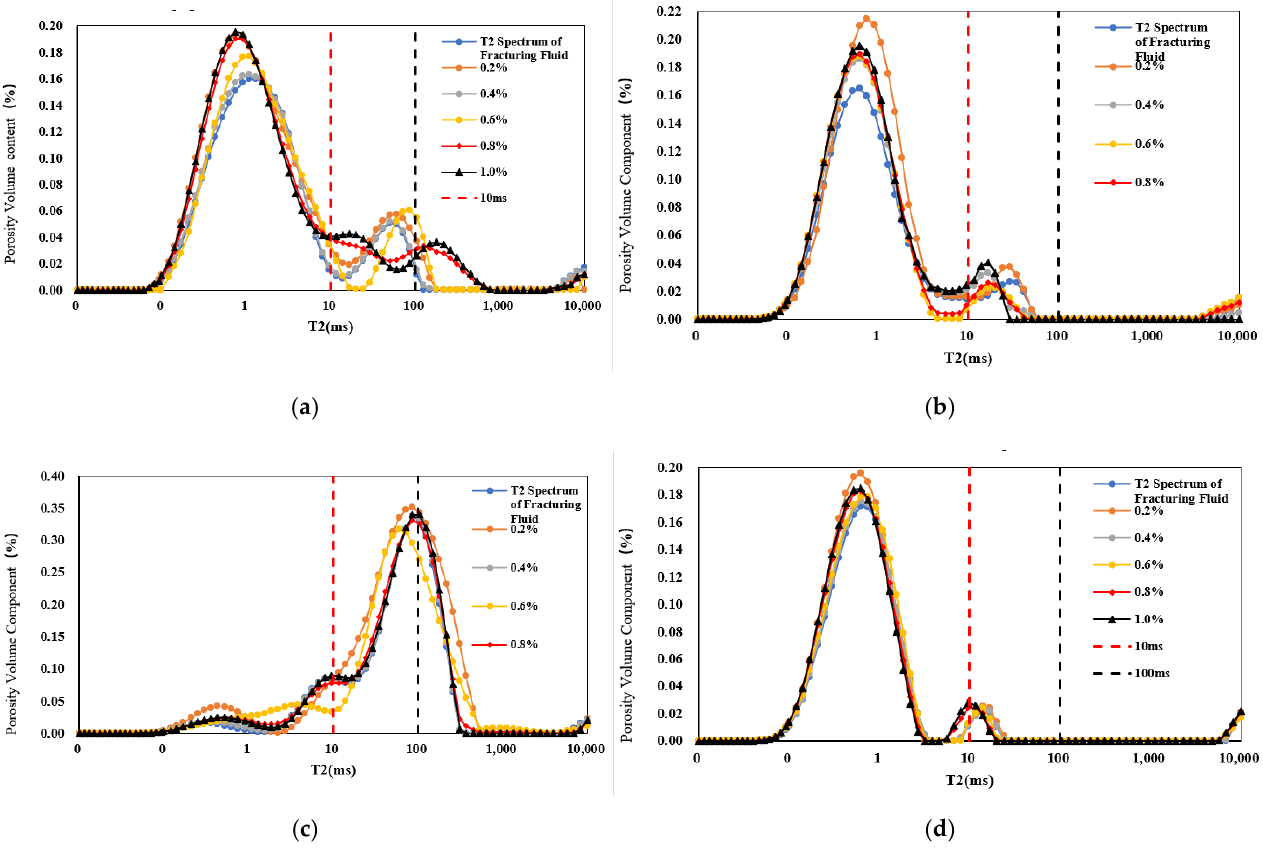
Figure 5. T2 spectrums of four rock samples under different concentrations of foaming agent solutions. ( a ) Rock sample 1; ( b ) Rock sample 2; ( c ) Rock sample 3; ( d ) Rock sample 4.